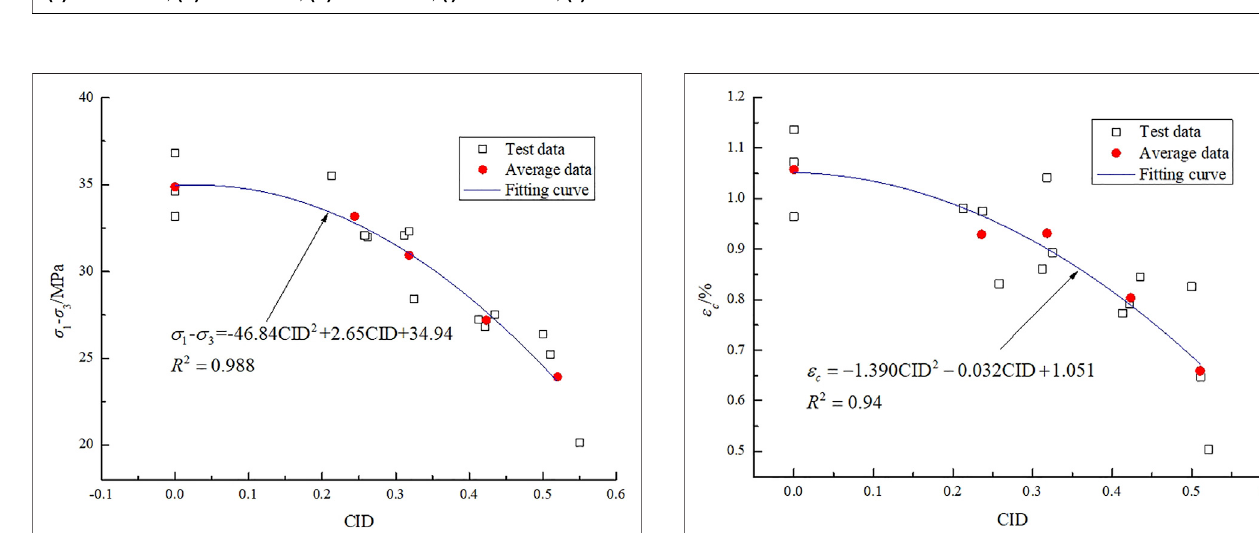
FIGURE6| DeviatoricstressandstraincurvesofdifferentCIDofcoalsamples: (A) CID (cid:2) 0.000; (B) CID (cid:2) 0.000; (C) CID (cid:2) 0.237; (D) CID (cid:2) 0.258; (E) CID (cid:2) 0.312; (F) CID (cid:2) 0.318; (G) CID (cid:2) 0.413; (H) CID (cid:2) 0.435; (I) CID (cid:2) 0.500; (J) CID (cid:2) 0.521.